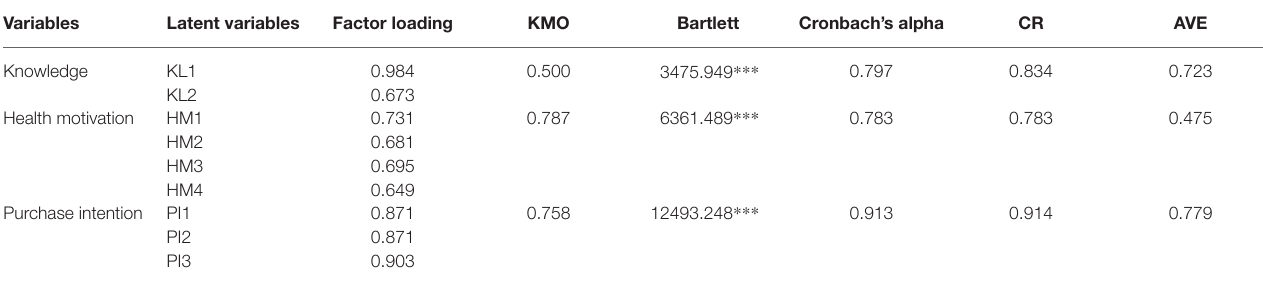
TABLE 2 | Validity and reliability of study variables.